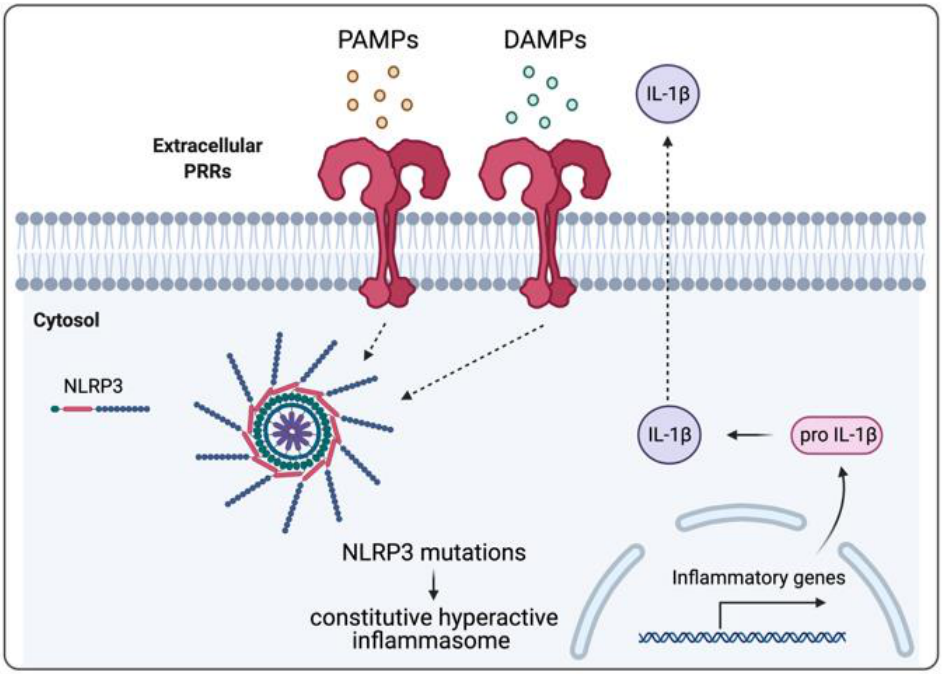
Figure 3. Inflammasome activation. Defects in the NLRP3 gene result in constitutive activation of the inflammasome and a consequence dysregulation of IL-1β production.